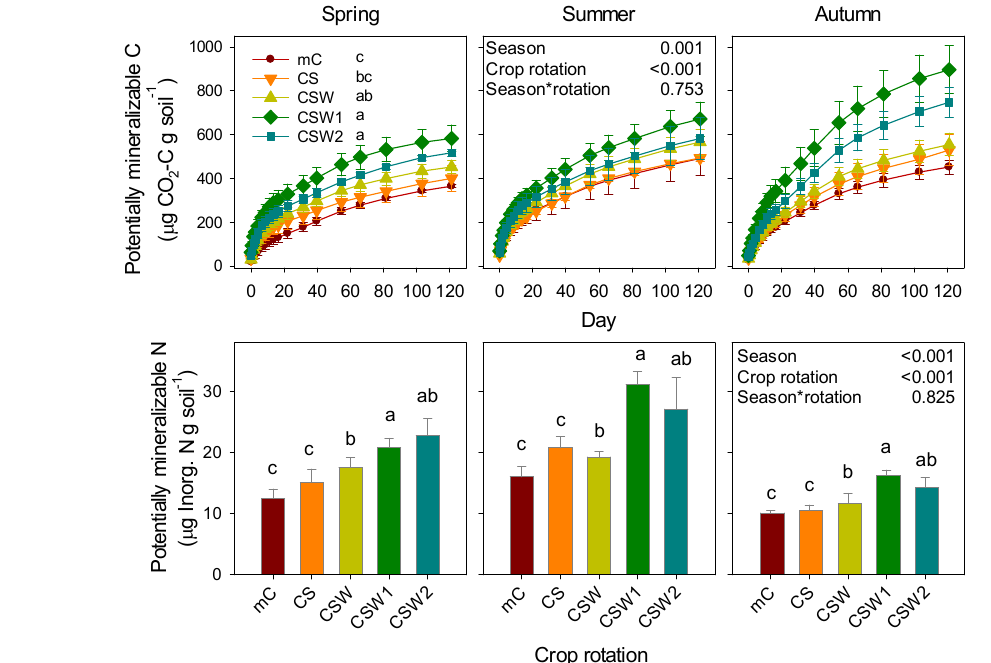
Figure 1. Potentially mineralizable carbon (top row panels) and potentially mineralizable nitrogen (bottom row panels). Crop rotation abbreviations are: monoculture corn (mC), corn–soy (CS), corn–soy–wheat (CSW), corn–soy–wheat with red clover cover crop (CSW1), and corn–soy–wheat with red clover + rye cover crops (CSW2). Means are shown and error bars are standard errors ( n = 4). P values from ANOVA results are shown for each variable with the main effects (season and crop rotation) and the interaction, as well as significant differences from post hoc results shown as lowercase